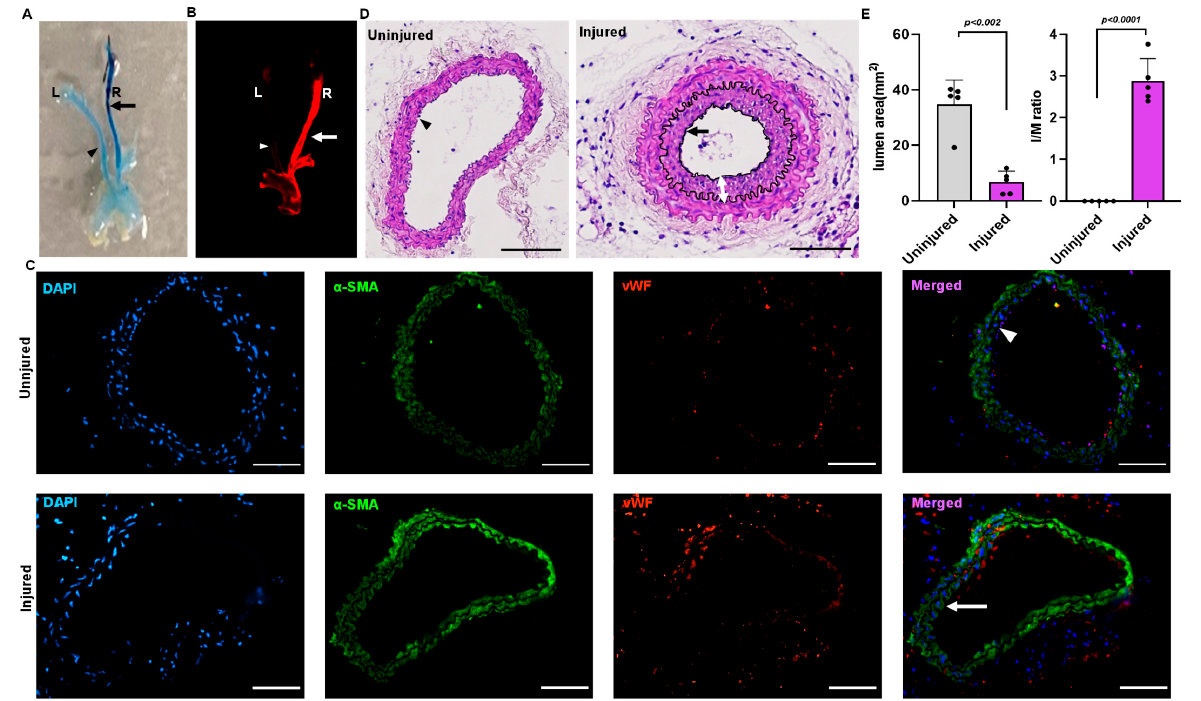
Figure 1. Mouse model of endothelial denudation. ( A ) Evans blue staining of right injured carotid artery and left uninjured carotid artery at day 1. ( B ) Infrared imaging of the right injured carotid artery and left uninjured carotid artery at day 1 using the LI-COR Odyssey machine, with Evans blue fluorescence measured at 700 nm. ( C ) Immunofluorescence staining of the sections dissected from the injured and uninjured carotid artery at day 1. Scale bar = 50 μ m. ( D ) Hematoxylin and eosin staining of the uninjured and injured carotid artery 4 weeks after surgery. Scale bars, 50 μ m. ( E ) Quantification of lumen area and IM ratio. The arrow indicate the injured artery, and the arrowhead indicates the uninjured artery. The double arrow indicates the thickness of the neointima. All values are mean ± SD ( n = 5) compared to the uninjured vessel using the Mann–Whitney U test.